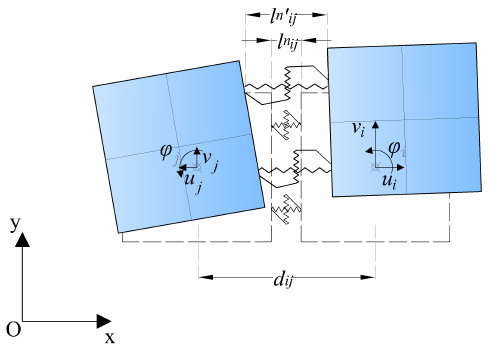
Figure 9. Strain measure of the model